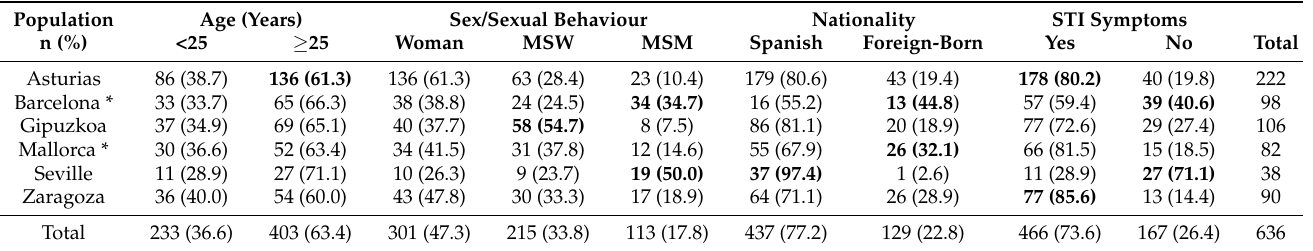
Table 1. Clinical and epidemiological characteristics of the 636 cases of infection by Chlamydia trachomatis , in which the ompA genotype was obtained